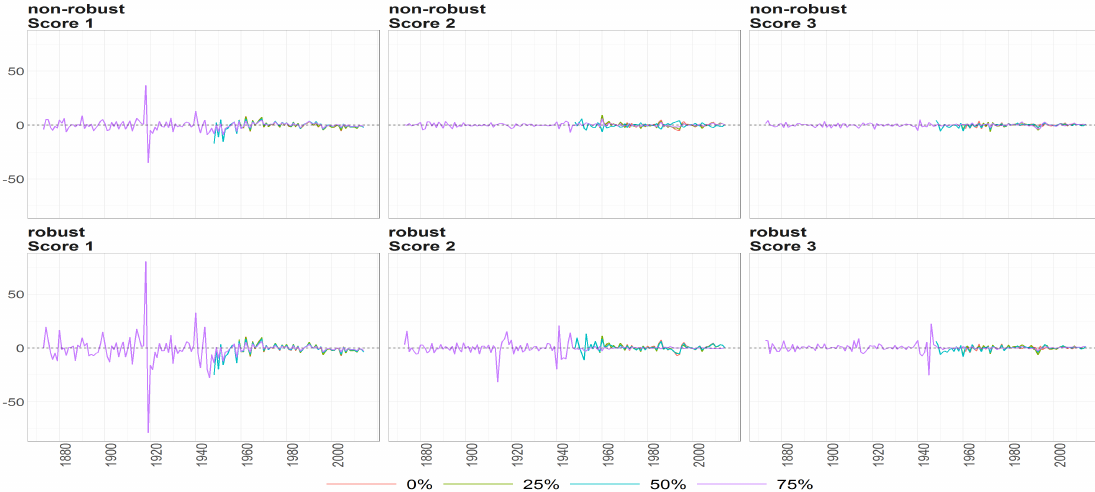
Figure 16. The scores (y axis) over the time (x axis) obtained using PPCA for Males of Life Expectancy at Birth. Colours of lines correspond to the scores calculated on subsample where are different levels of maximum missing values per observation (0%, 25%, 50% and 75%, refer to legend). The plots placed in the first row correspond to the results using non- robust standardization of entry data, where the second row correspond to robust standardisation. The plots of scores are ordered by